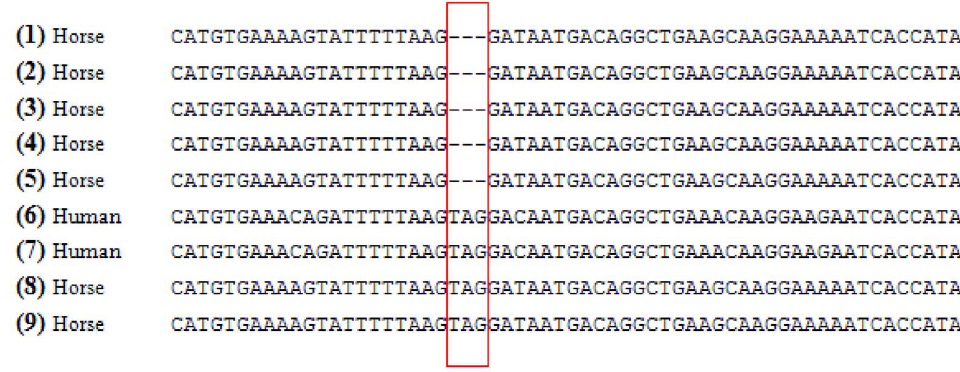
Figure 3. Comparison of equine PLCz1 transcript variants with and human PLCz1 . Transcript variants (1) ENSECAT00000012304, (2) ENSECAT00000012372, (3) XM_001497766.3, (4) JX545317, (5) JX545319, (6) ENST00000318197, (7) NR_073075.1, (8) JX545318, and (9) JX545320 are presented. (1–4) Human and equine variants without a premature termination codon (PTC) in sequences are indicated. (5–9) A PTC is activated within human and equine variants at similar positions (c.136). The PTC region is highlighted by a red box.